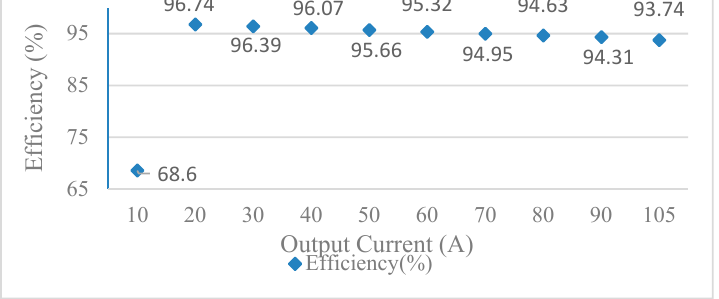
Figure 23. 50% load current statement of three resonant inductors. (Time: 2 µ s/div; Vgs 2: 10 V/div;